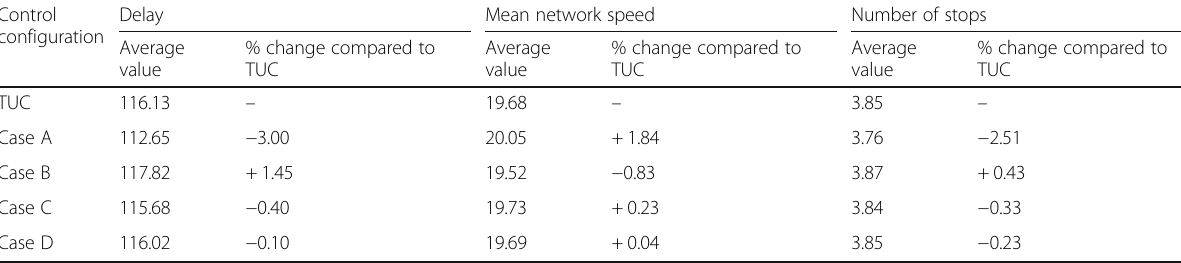
Table 3 Simulation results for demand scenario 3 (congested traffic conditions) Control configuration